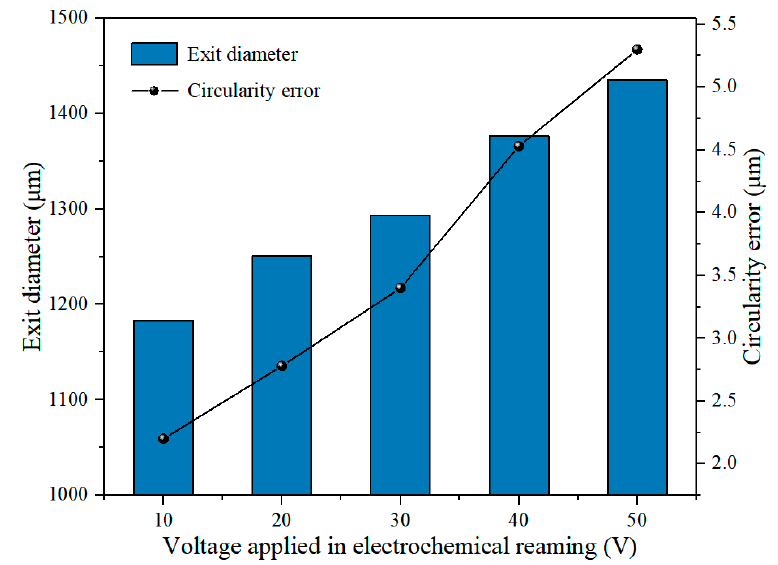
Figure 11. Variation of exit diameter and circularity error with applied voltage in electrochemical reaming.